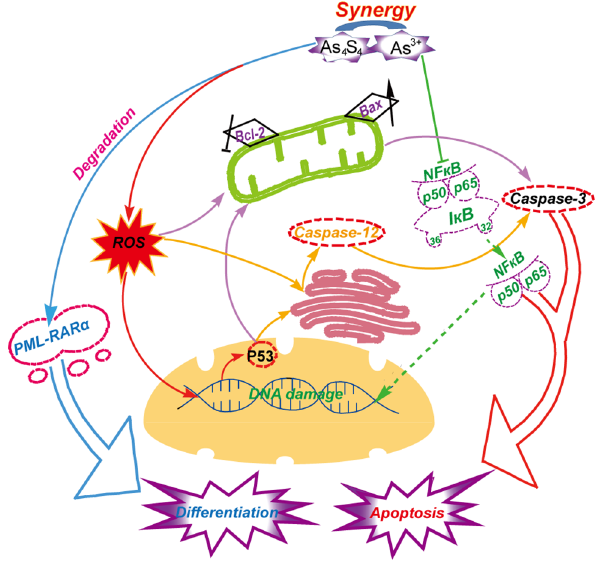
Fig 8. Mechanism for the synergistic effects of As 4 S 4 and As 3+ on apoptosis and differentiation of acute promyelocytic leukemia cells.